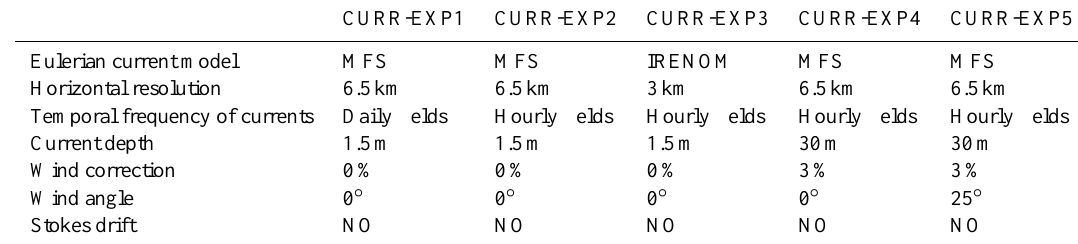
Table 1. Table of sensitivity experiments to horizontal current resolution, time frequency and depth of currents.